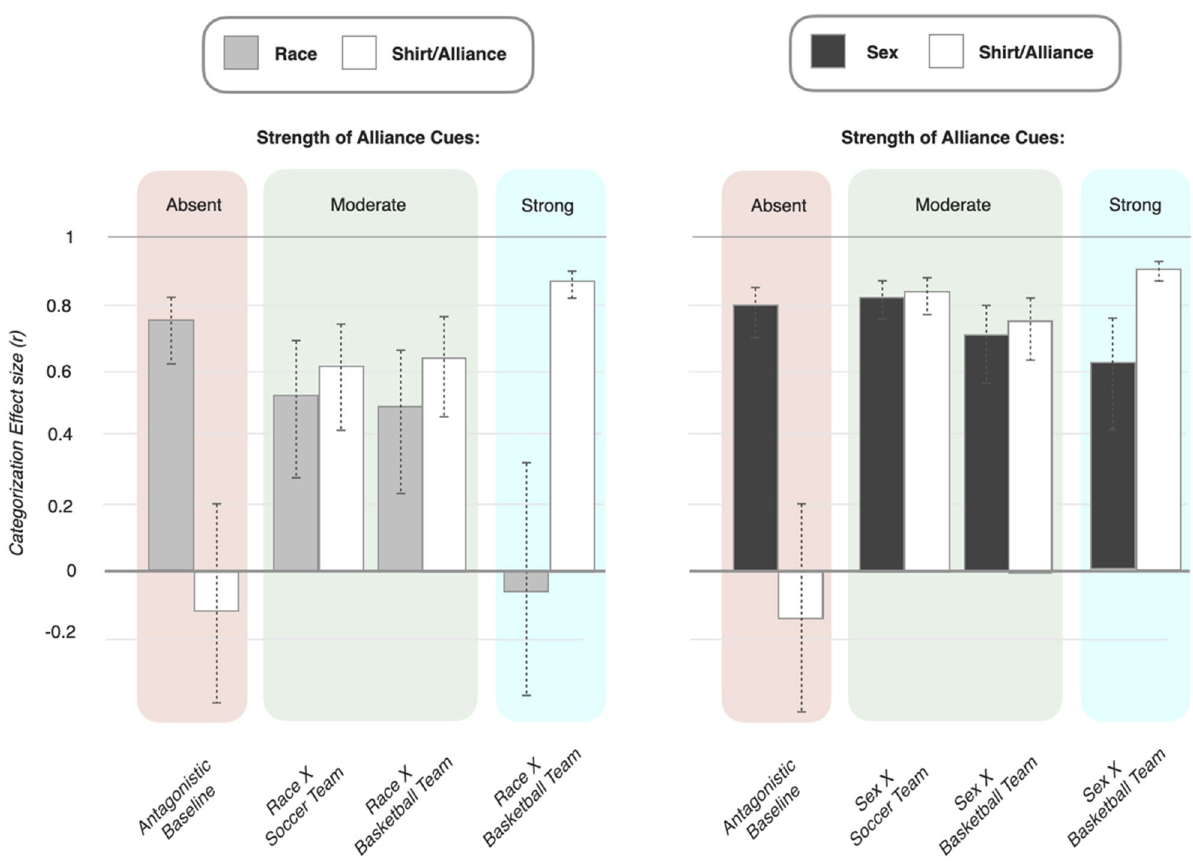
Figure 2. Categorization effect sizes by both race and sex when crossed with alliance membership (in different sporting contexts), using standard t-tests and reported as r ’s. Error bars are 95% confidence sex ( r = 0.80), and no appreciable categorization by shirt color. (Shirt color in this baseline condition signified nothing, and was included so that shirt color differences would not be confounded with alliance information across conditions. In fact, for thoroughness—and to unconfound the effect of adding alliance information from the effect of adding antagonism to the study stimuli—two baseline conditions were: One in which targets spoke about positive-to-neutral events ( positive baseline ), and a second in which they spoke about antagonistic events ( antagonistic baseline ). For simplicity, only the antagonistic baseline is presented here, as it is the minimal pair with all three alliance conditions. Notably, there was no appreciable change in categorization by either race (∆ r = 0.04) or sex (∆ r = 0.02) across these two different baselines, although categorization by race did increase descriptively when antagonism was added ( positive r = 0.69, antagonistic r = 0.75), in contrast to sex ( positive r = 0.84, antagonistic r = 0.80; see SOM for full results)). The crucial question was what would happen when race and sex are crossed with team membership—the experimental manipulation that should (1) engage the mind’s alliance-tracking leading to categorization by team and (2) that should differentially reduce categorization by race compared to sex. Results are presented in the three conditions to the right of the baselines in Fig. 2 (two featuring moderate strength alliance cues, and one strong alliance cues; see Box 2 for explanation). As can be seen, there was substantial categorization by team membership ( shirt/alliance ) in all three condi- tions. Importantly, this categorization cannot simply be attributed to the visual salience of the shirt colors—as the exact same visual stimuli were present in the baseline conditions, but elicited no categorization. Thus, participants were keeping track of and categorizing each target by their respective team membership—the first prediction of the alliance hypothesis. The second and most important prediction of the alliance hypothesis is the differential reduction in race. As can be seen, compared to the baseline condition, categorization by race was reduced more than was sex, and this was true across all three alliance conditions. To fully unpack this result it is helpful to understand what each of the three alliance conditions were. In all three, either race or sex was crossed with verbally and visually-marked team membership. Two of the three conditions featured moderately-strong alliance cues in the stimuli (in which the visual cues of team mem- bership were removed during the recall task), whereas the third and last condition featured strong alliance cues in the stimuli (in which the visual cues of team membership were retained during the recall task). This variation in the strength of alliance cues provided both a within-study replication and a more continuous measurement of the effect of alliance cues on race and sex (see Box 2 and SOM). Roughly speaking, the true effect of the alliance